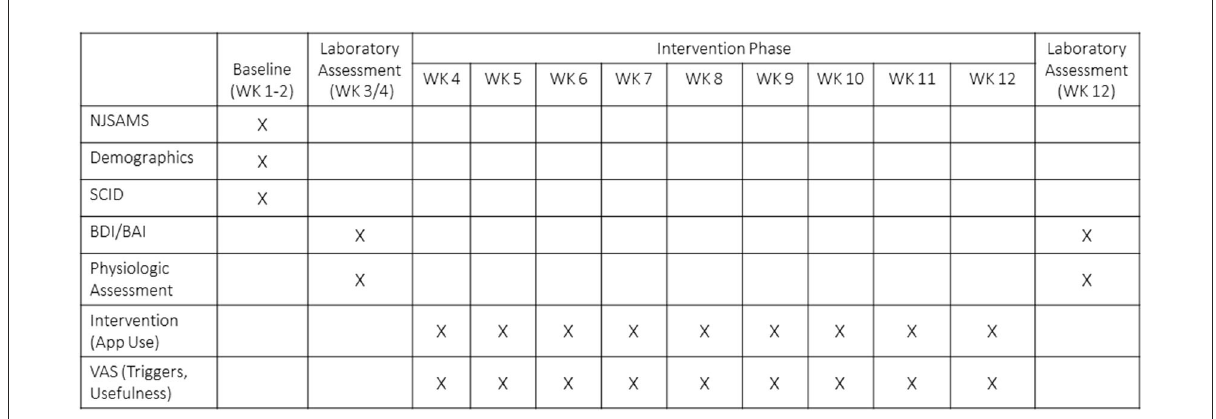
reported here; see Supplementary material in Price et al.